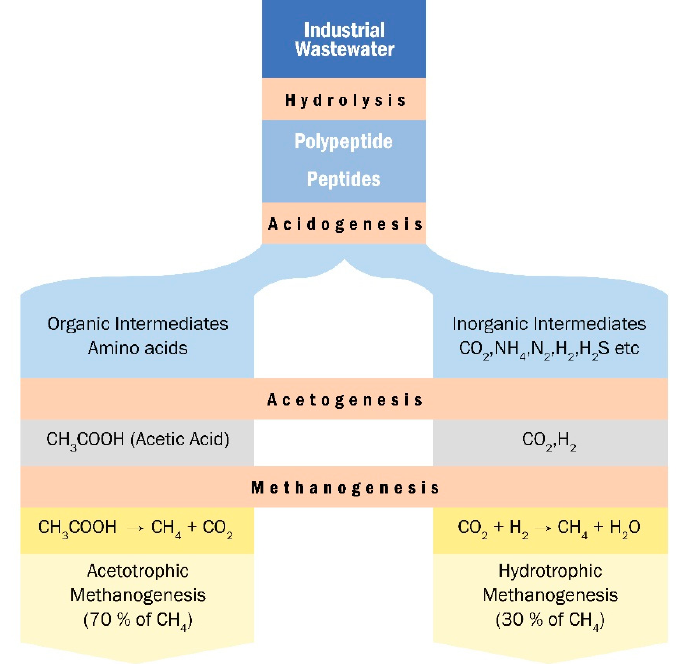
Figure 4. The anaerobic biodegradation of gelatin-rich protein.